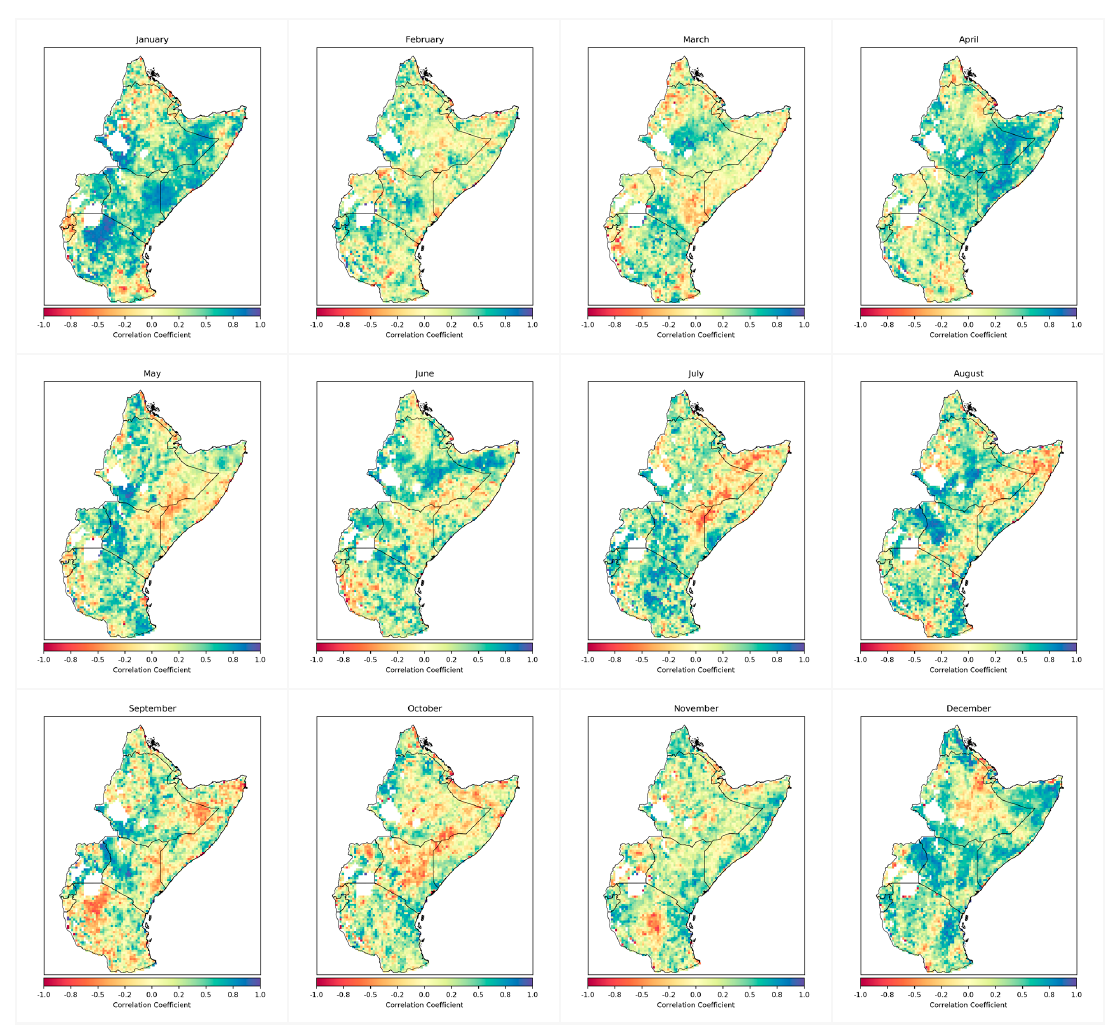
Figure A5. Pearson correlation coefficient for monthly soil-moisture estimates and the ESI (2003–2016); ESI lagged by one month.